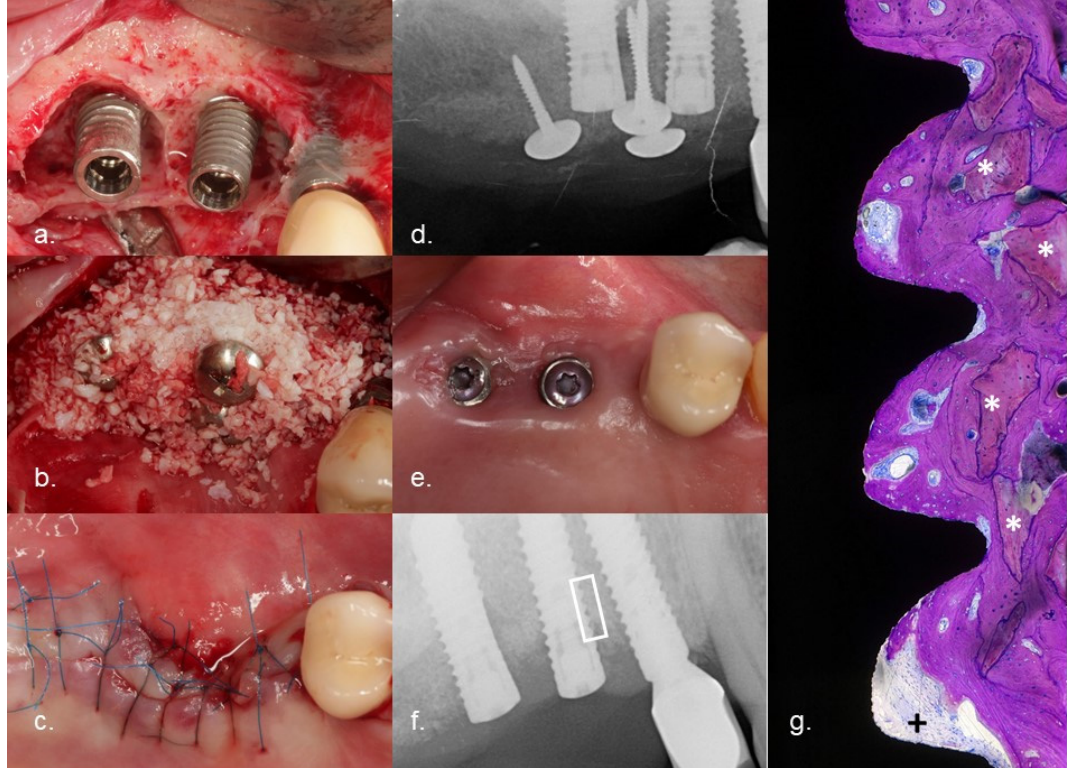
Figure 5. Clinical course of a failed case: ( a ) implants 15 and 16 with severe combined intra- and supra-osseous bone defects (RP Class 3); ( b ) augmentation after electrolytic cleaning with a combination of mineralized bovine bone mineral and autogenous bone using the Umbrella technique; ( c ) tensionless suturing after the crestal mobilization of the flap; ( d ) radiograph demonstrating the augmented volume; ( e ) clinical situation 6 months after the flap surgery, exposure of the flap caused some loss of augmented volume; ( f ) radiograph 11 months after surgery (the implant had to be removed because of suppuration); ( g ) histology with a field of interest in the augmented area pointing out regenerated bone and reosseointegration to the implant surface. * Particles of deproteinized bovine bone mineral, + pus.